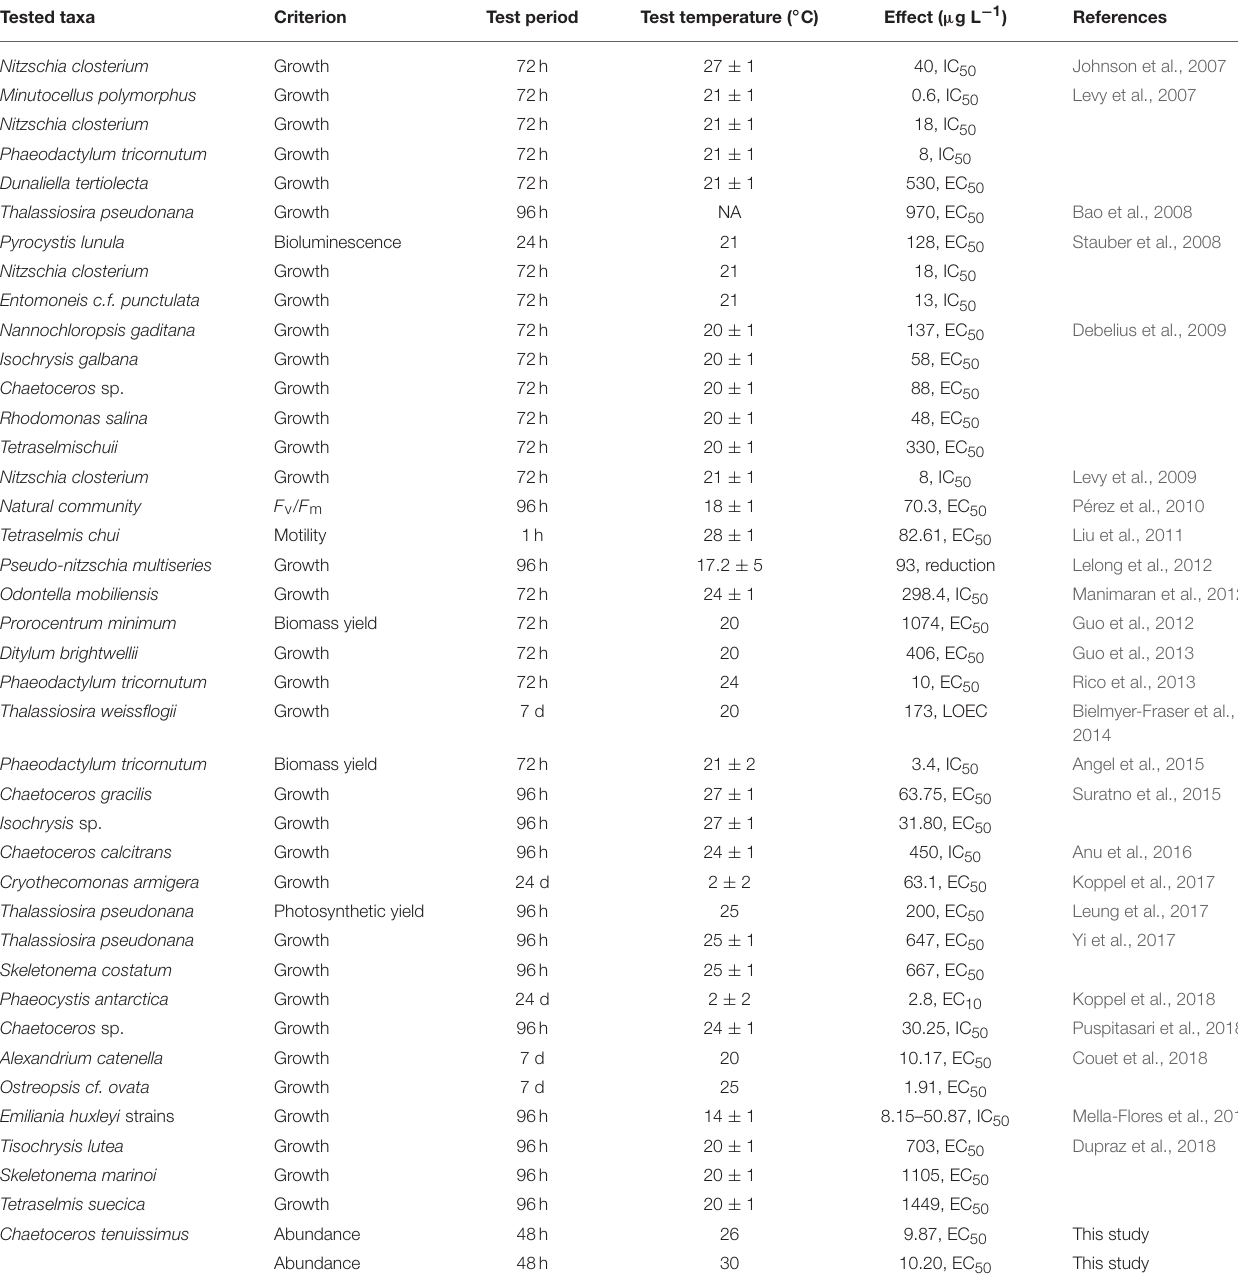
TABLE 1 | Overview of recent Cu toxicity data for marine